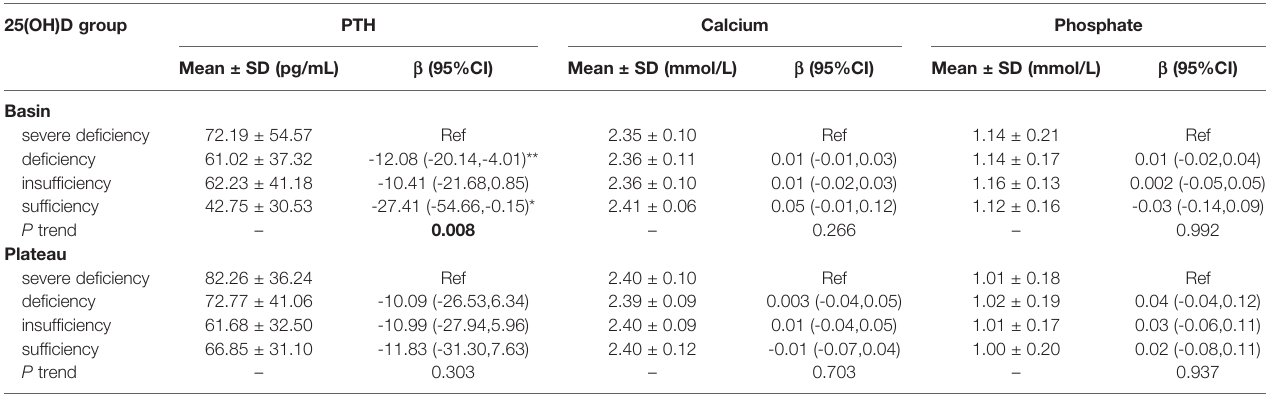
TABLE 4 | Association between serum 25(OH)D with PTH, calcium, and phosphate in basin and plateau. 25(OH)D group PTH Calcium